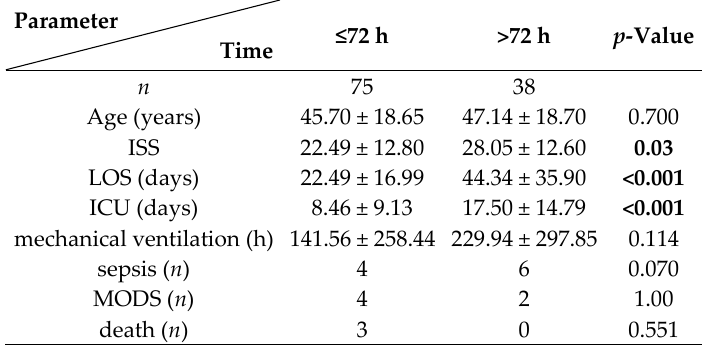
Table 4. Stratification analysis (ANOVA and chi square test) for the time to surgery ( < 72 vs. > 72 h). Parameter